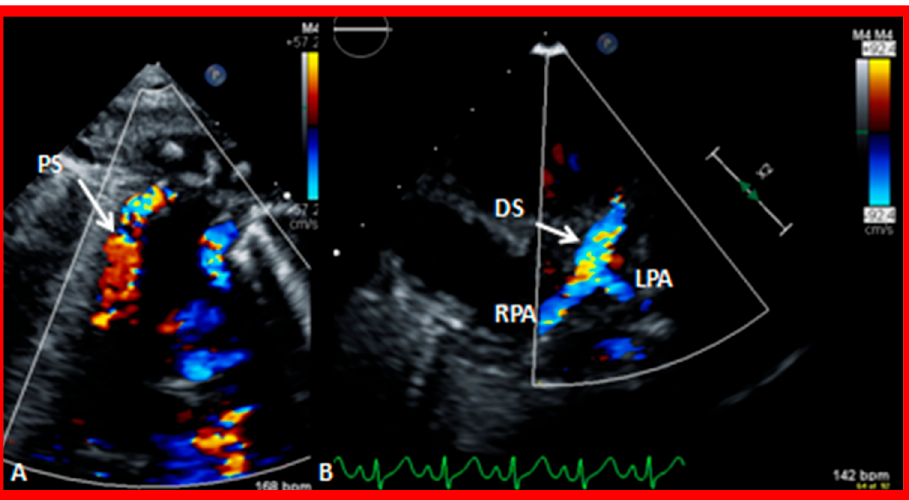
Figure 2. Echo–Doppler recordings acquired with a transducer positioned in the suprasternal notch view illustrating the proximal portion of the shunt (PS) by color Doppler ( A ). With a somewhat separate angulation ( B ), the distal part of the shunt (DS) is shown with flow into the right (RPA) and left (LPA) pulmonary arteries. Reproduced from [21].